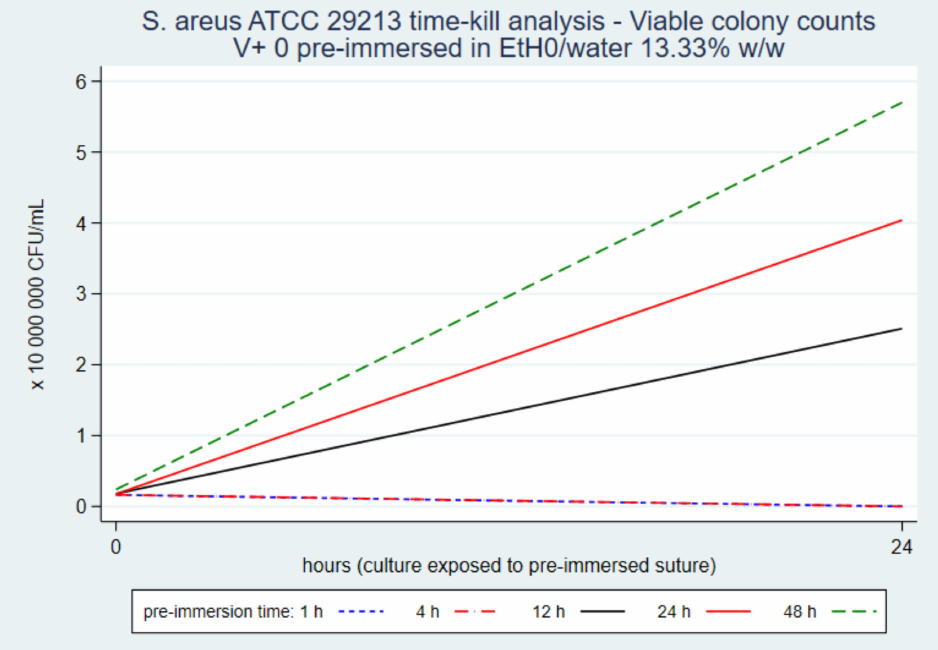
Figure 7. V+ 0 in 13.3% w / w 24-h time-kill